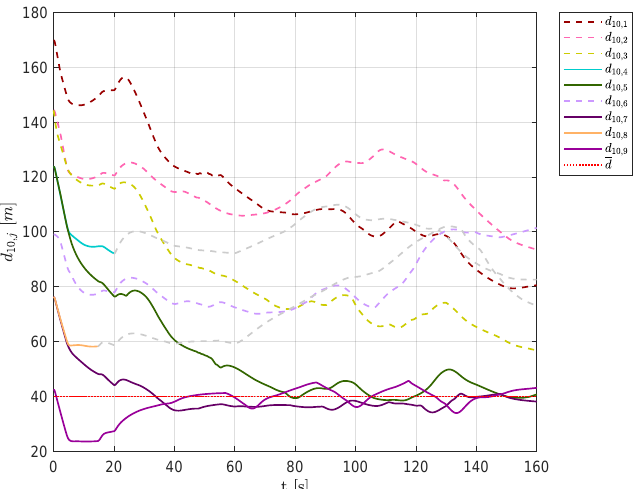
Figure 18. Scenario #1—10 aircraft: distances between UAV 10 and the other swarm vehicles. Solid lines are used for visible aircraft and dashed gray lines are employed whenever they are no longer visible, whereas dashed colored lines are used for never visible UAVs. The desired distance is highlighted using a dotted red line.